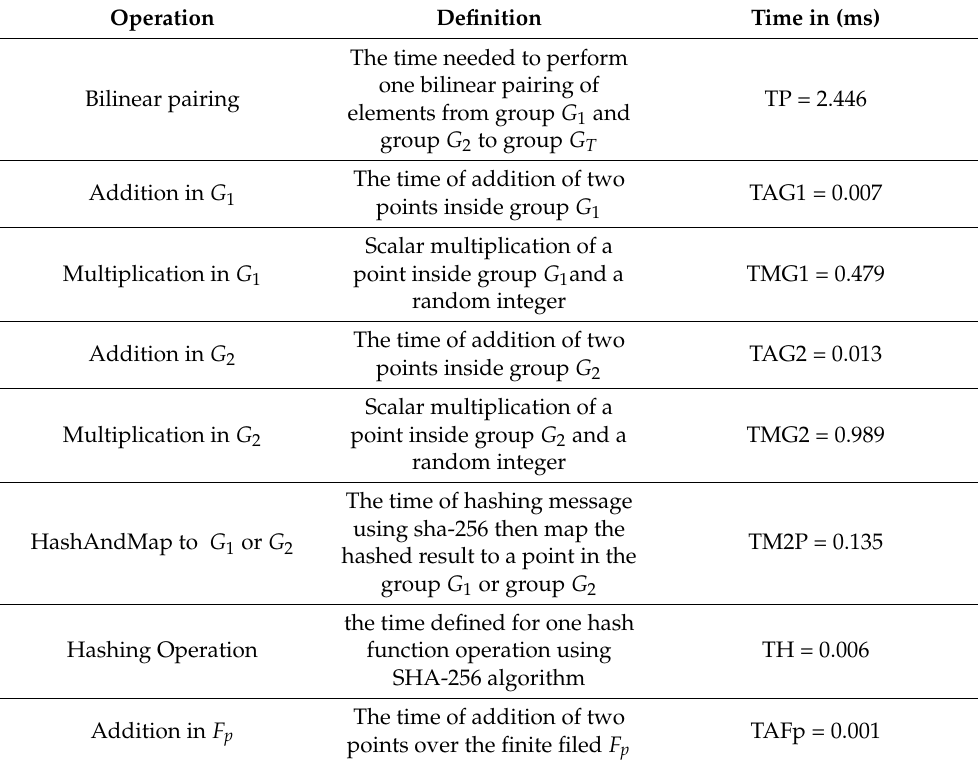
Table 4. Average execution time of the BN254 pairing functions used in our